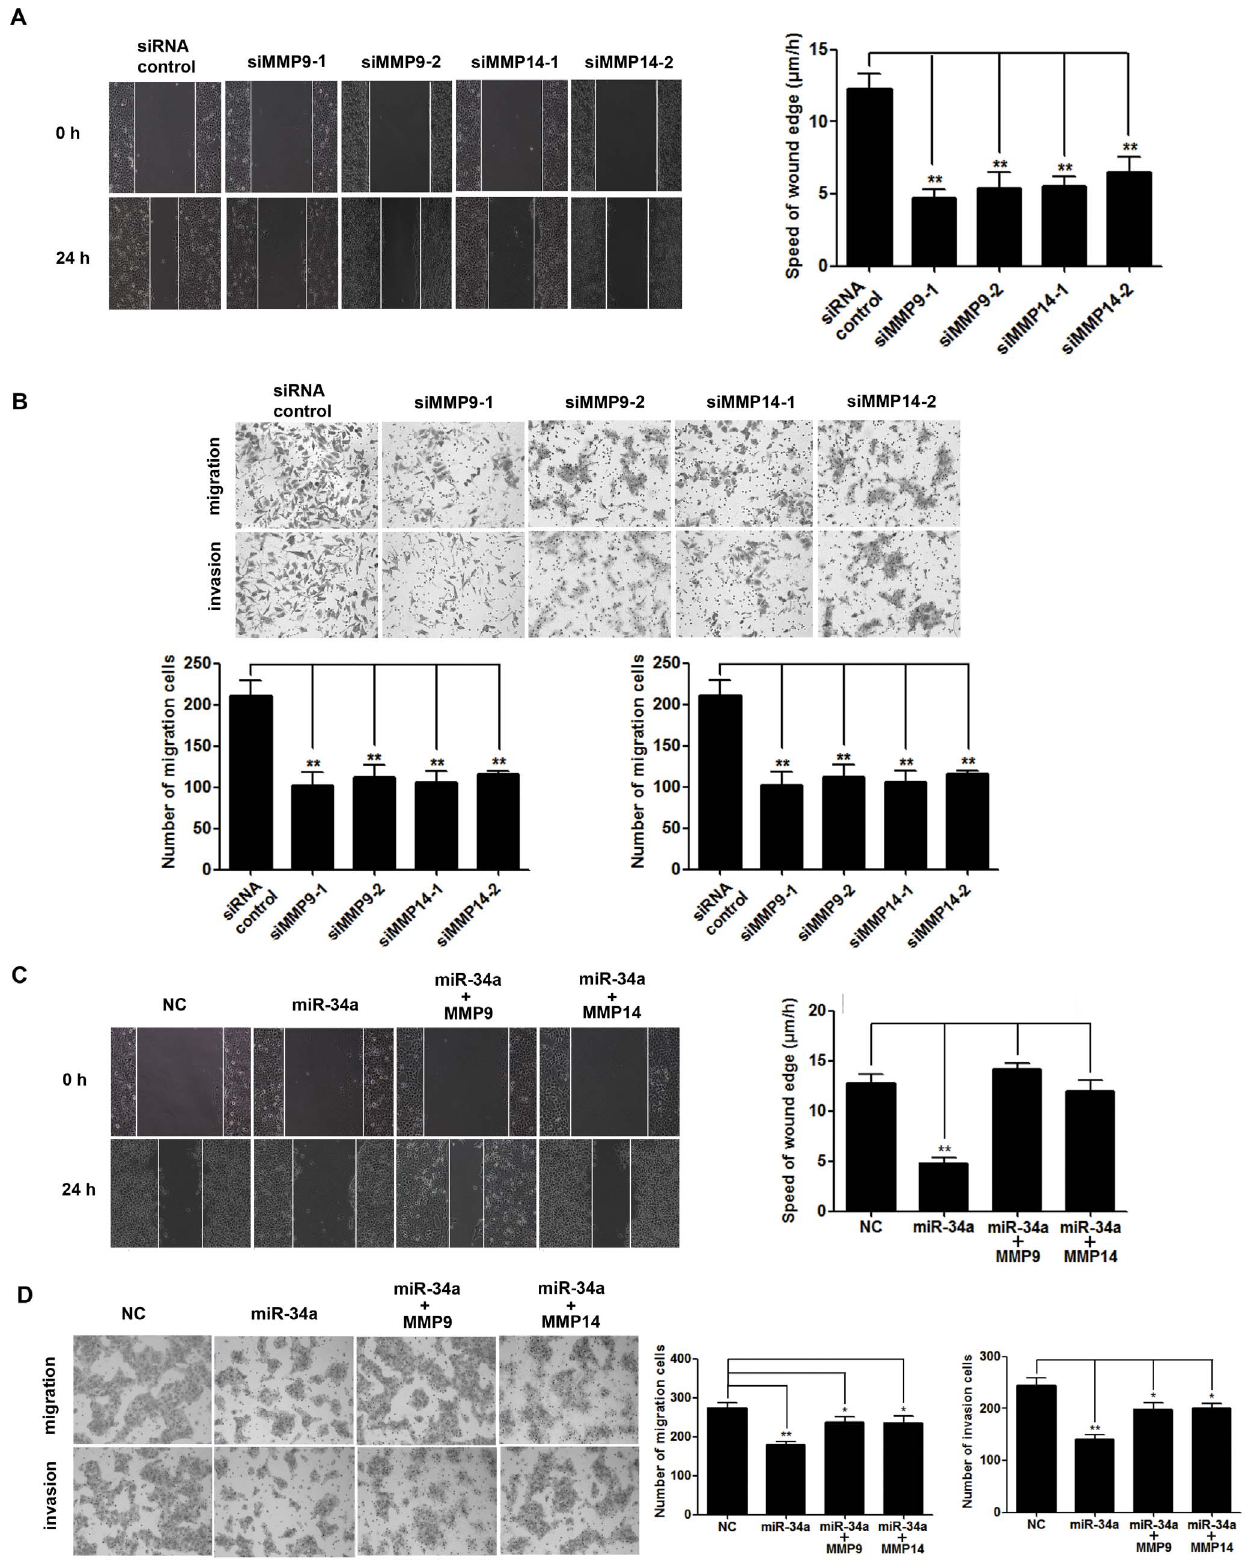
Figure 3. Inhibition of MMP9 and MMP14 was responsible for the TSCC cells migration and invasion effects of miR-34a. (A) and (B), Inhibition of cell migration and invasion by knockdown of MMP9 and MMP14. CAL27 cells were transfected with siRNA control, siMMP9-1, siMMP9-2, siMMP14-1, and siMMP14-2 as indicated. (C) and (D), MMP9 and MMP14 overexpression partially rescues miR-34a-reduced cell migration and invasion. Representative photomicrographs of wound healing and transwell assays results for stable expression miR-34a CAL27 cells transfected with pcDNA3.0-MMP9 (MMP9) or pcDNA3.0-MMP14 (MMP14) ( 6 200 magnification, ** P , 0.01). doi:10.1371/journal.pone.0108435.g003 PLOS ONE |